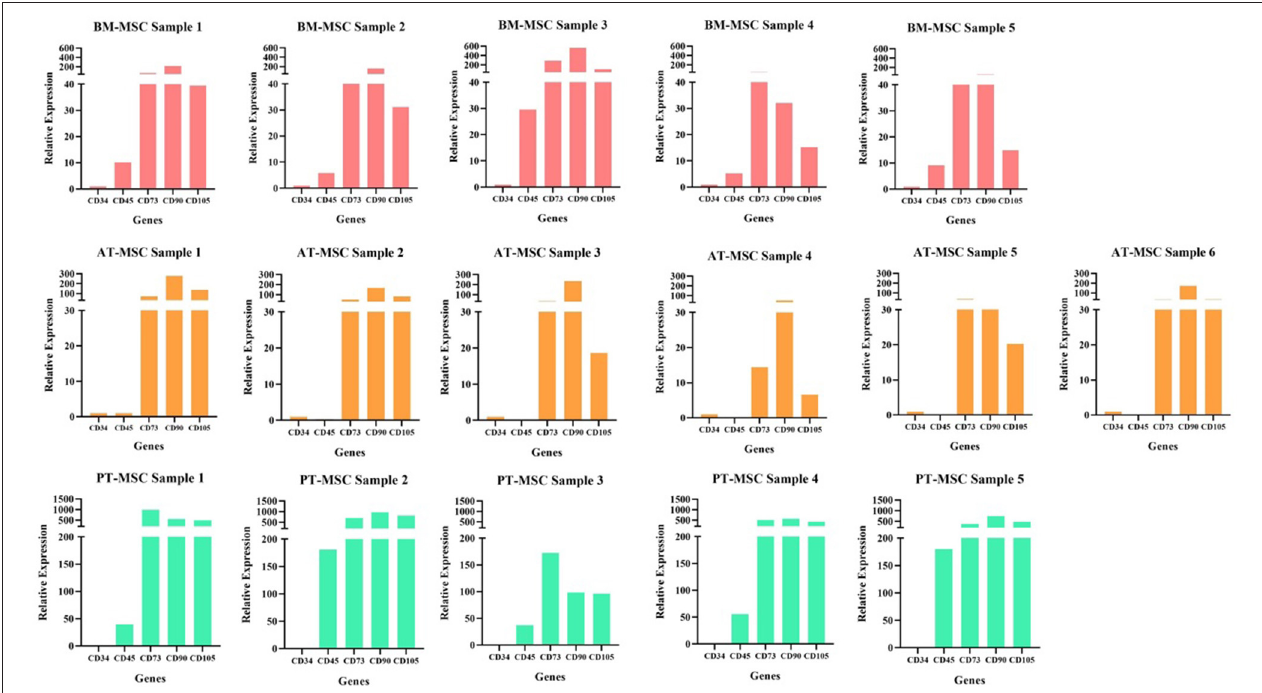
FIGURE 3 | Individual samples relative expression of hematopoietic (CD34 and CD45) and mesenchymal markers (CD73, CD90, and CD105) in bovine fetal adipose tissue (AT-MSC), bone marrow (BM-MSC), and placenta (PT-MSC) mesenchymal stem cells.